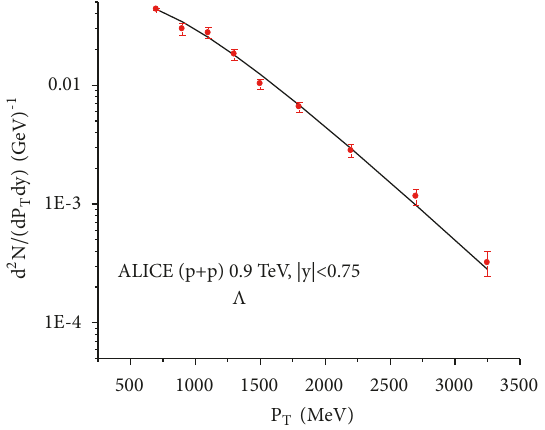
Figure 5: Transverse momentum spectrum of lambda Λ .